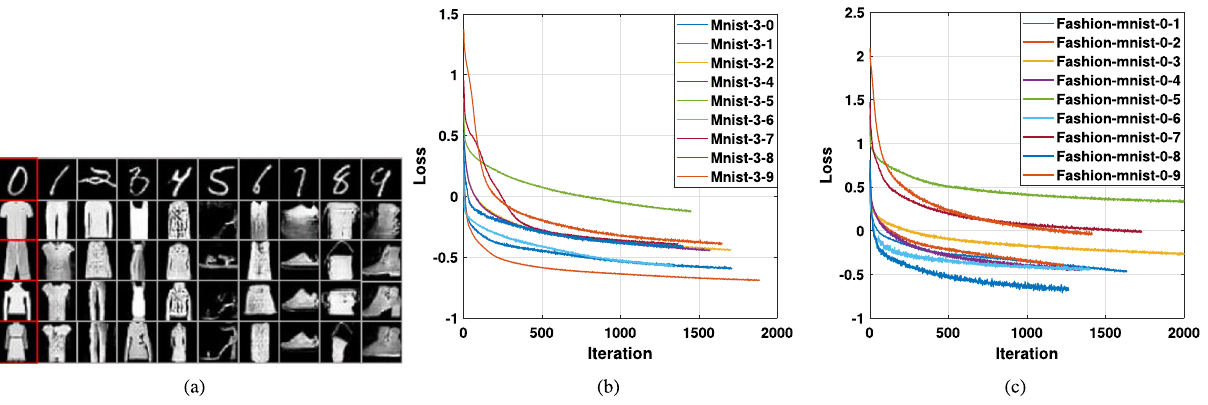
Figure 10. Embedding results and loss value on MNIST and Fashion-MNIST datasets. ( a ) The red frames represent the ground-truth 32 pixels 32 pixels images x , and columns 2 to 10 represent the embedding results, × G z ∗ , y , by the GE with various class labels y . ( b ) Embedding loss values vs. the number of optimisation steps (cid:30) (cid:31) on MNIST. ( c ) Embedding loss values vs. the number of optimisation steps on Fashion-MNIST datasets.